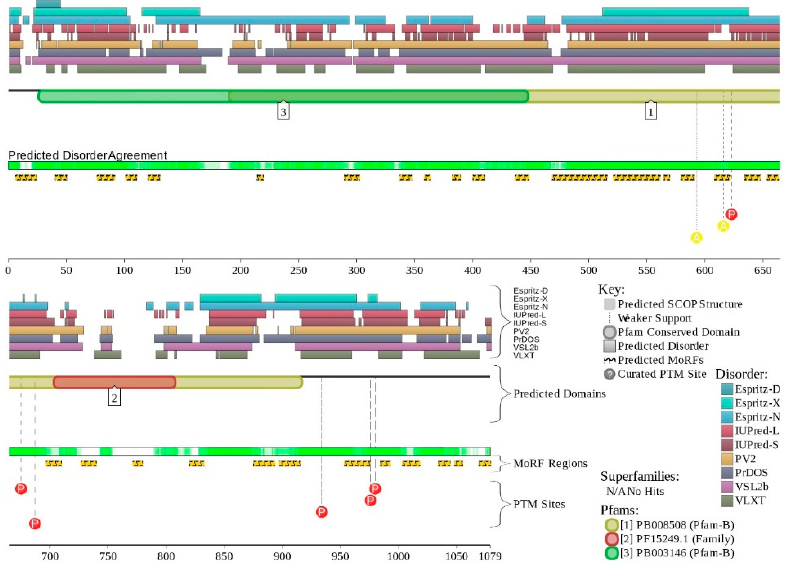
Figure 24. D 2 P 2 functional disorder profile of human GLTSCR1L/BICRAL protein (UniProt ID: